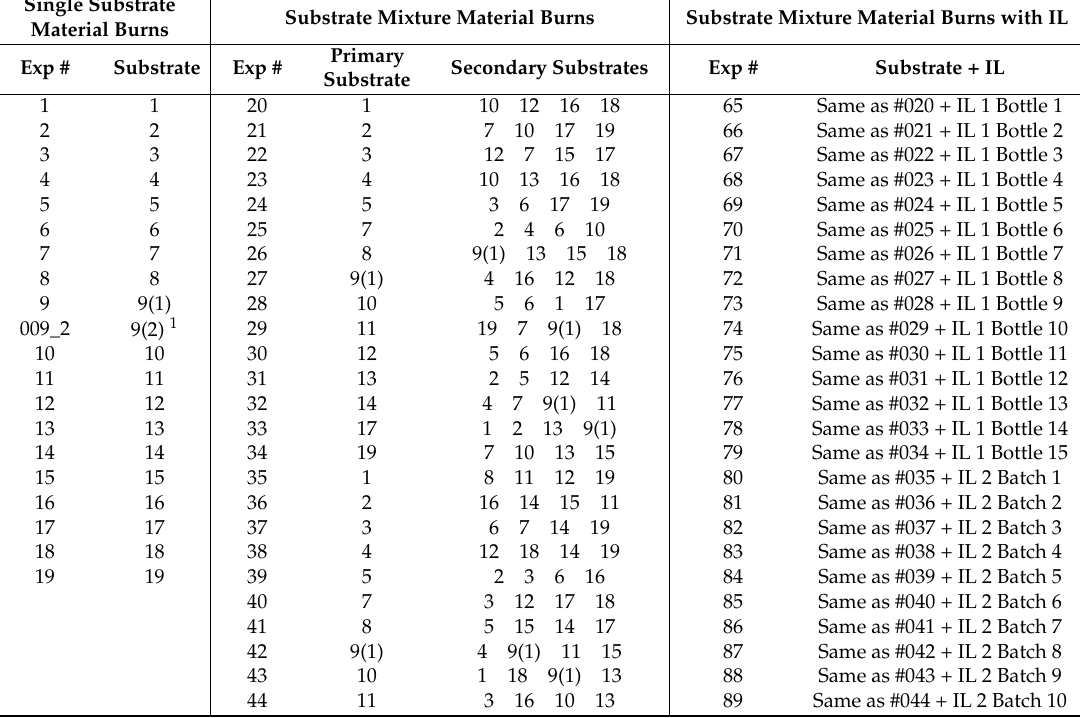
Table 2. Overview of all conducted burn experiments. Primary substrates constituted 60% by weight. Secondary materials constituted 10% each. Substrate numbers refer to Table 1. Two different pieces of curtain were used in this study, indicated in bracketed numbers for experiments that included one of these batches. Detailed information about the bottles/batches of IL can be found in Table S1. Single Substrate Material